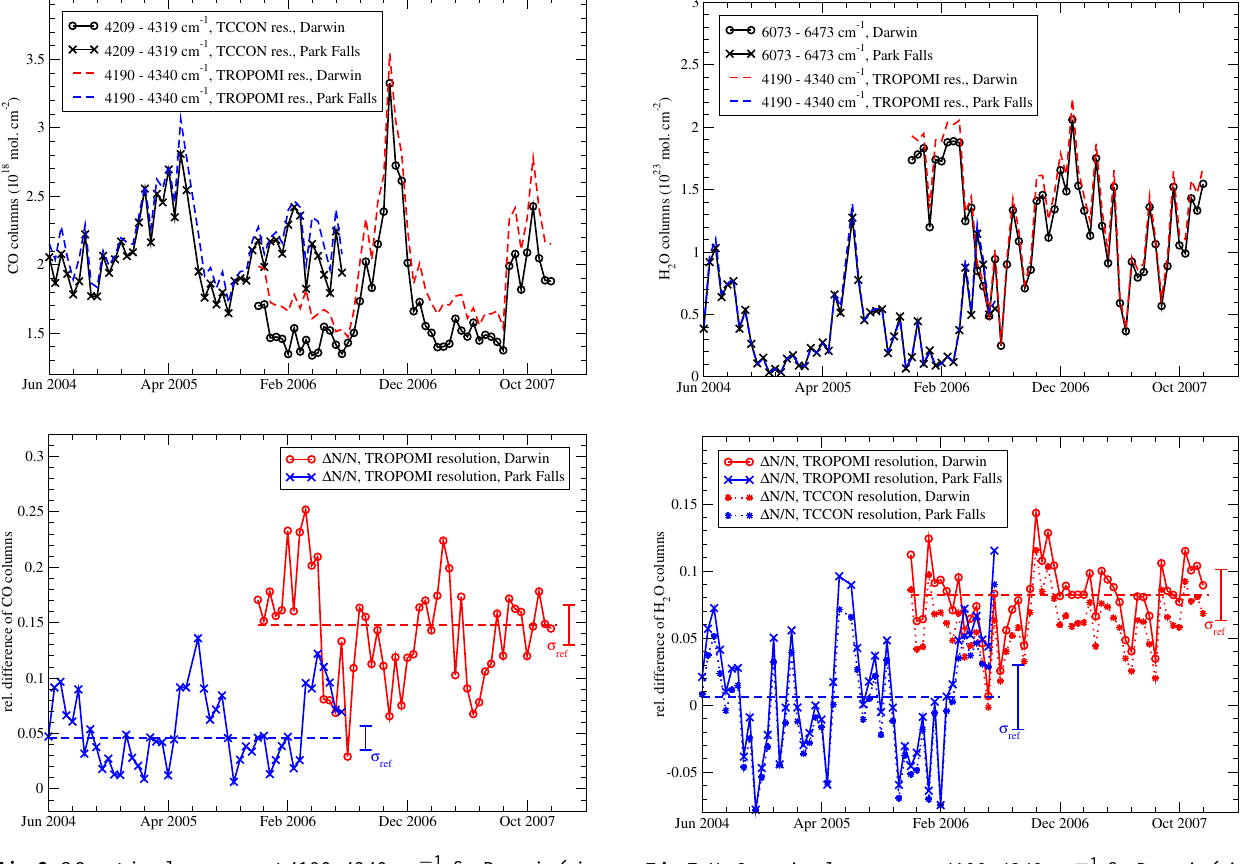
Fig. 7. H 2 O retrieval accuracy at 4190–4340cm − 1 for Darwin (cir- cles) and Park Falls (crosses). The upper panel shows the time- series, the lower panel shows the relative differences between columns retrieved at 4190–4340cm − 1 (for TROPOMI and original high resolution) and columns retrieved from window 4. Table 3. Fit diagnostics of the CO column retrievals for the TROPOMI